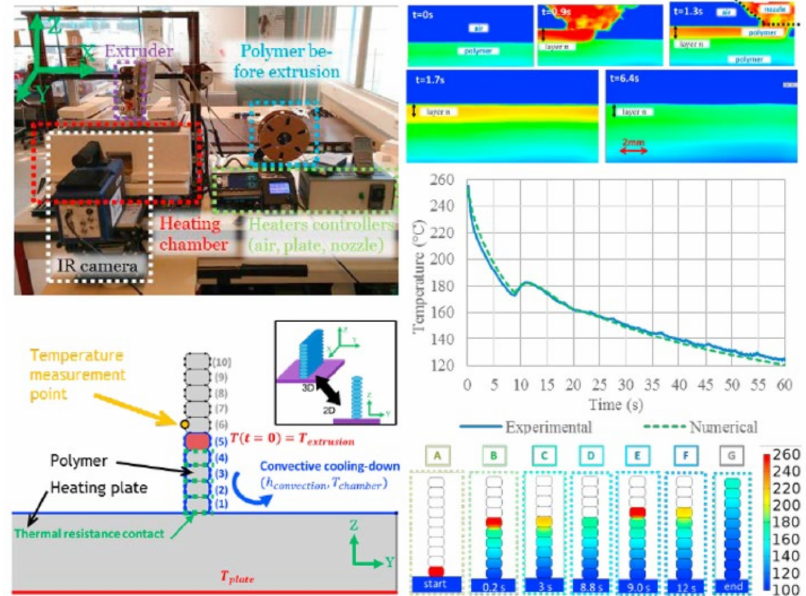
Figure 10. Experimental set-up showing the thermogram of the printed part and the location of the fixed points (reprinted with permission from